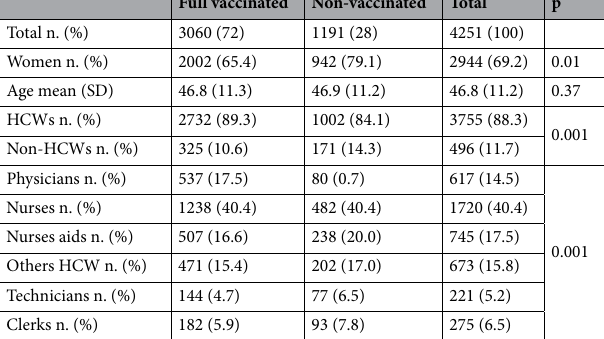
Table 4. Characteristics of full vaccinated and non-vaccinated health care workers at March 1, 2021.